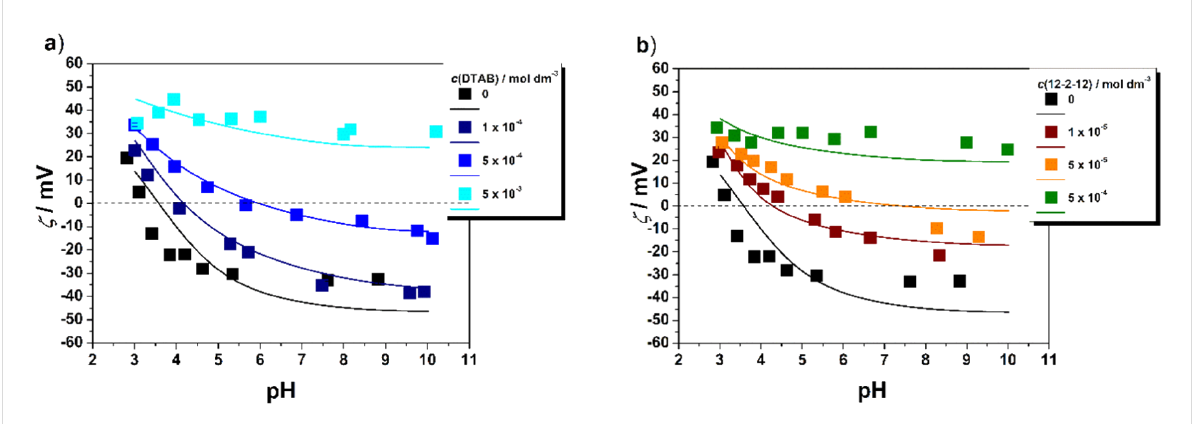
Figure 6: The zeta potential ( ζ ) of TNWs with and without surfactant in NaBr aqueous electrolyte solution, c (NaBr)/mol dm − 3 = 1 × 10 − 3 and at differ- ent a) DTAB concentrations, c (DTAB)/mol dm − 3 = (black square) 0, (dark blue square) 1 × 10 − 4 , (blue square) 5 × 10 − 4 , (light blue square) 5 × 10 − 3 ; b) c (12-2-12)/mol dm − 3 = (black squre) 0, (red square) = 1 × 10 − 5 , (orange square) 5 × 10 − 5 , (green square) 5 × 10 − 4 . γ (TNW)/g dm − 3 = 1 × 10 − 2 , θ = 25 °C. The modelling results of TNW zeta potential measurements with and without surfactant in NaBr aqueous electrolyte solution, c (NaBr)/mol dm − 3 = 1 × 10 − 3 are shown as the corresponding solid lines. The experimental results were fitted using surface complexation modeling (SCM).